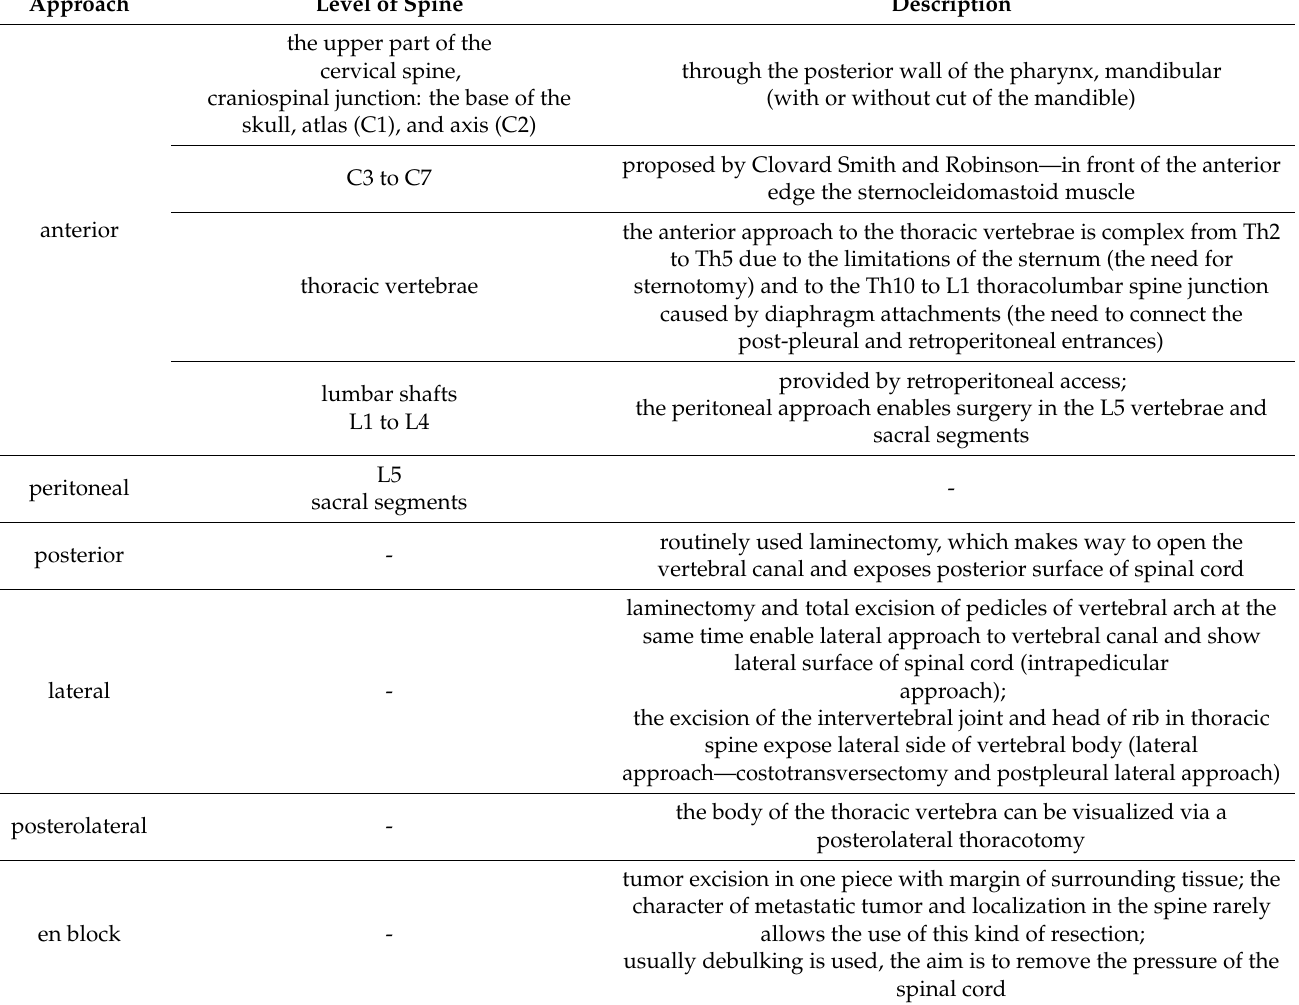
Table 3. Surgical approaches